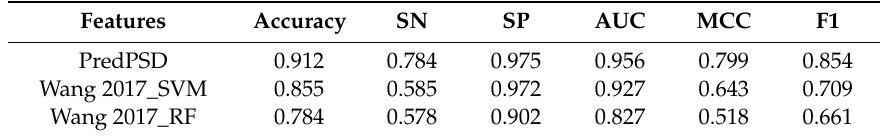
Table 2. Performance of all feature descriptors with GTB algorithms based on our training set and comparisons with existing methods